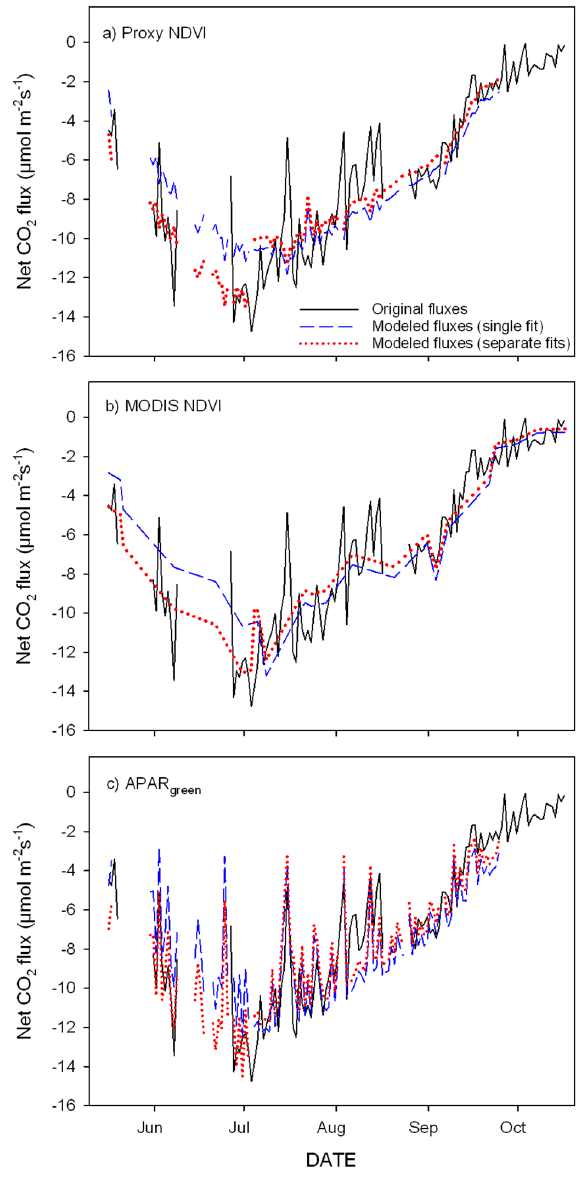
Figure 8. Time series of observed and modeled net CO 2 fluxes based on proxy NDVI (panel a ); MODIS NDVI (panel b ); and APAR green (panel c ). The original fluxes are shown as solid lines. Fluxes modeled using a single fit are shown as dashed lines, and fluxes modeled using two separate fits are shown as dotted lines. All results are for the E3 site in 2012.